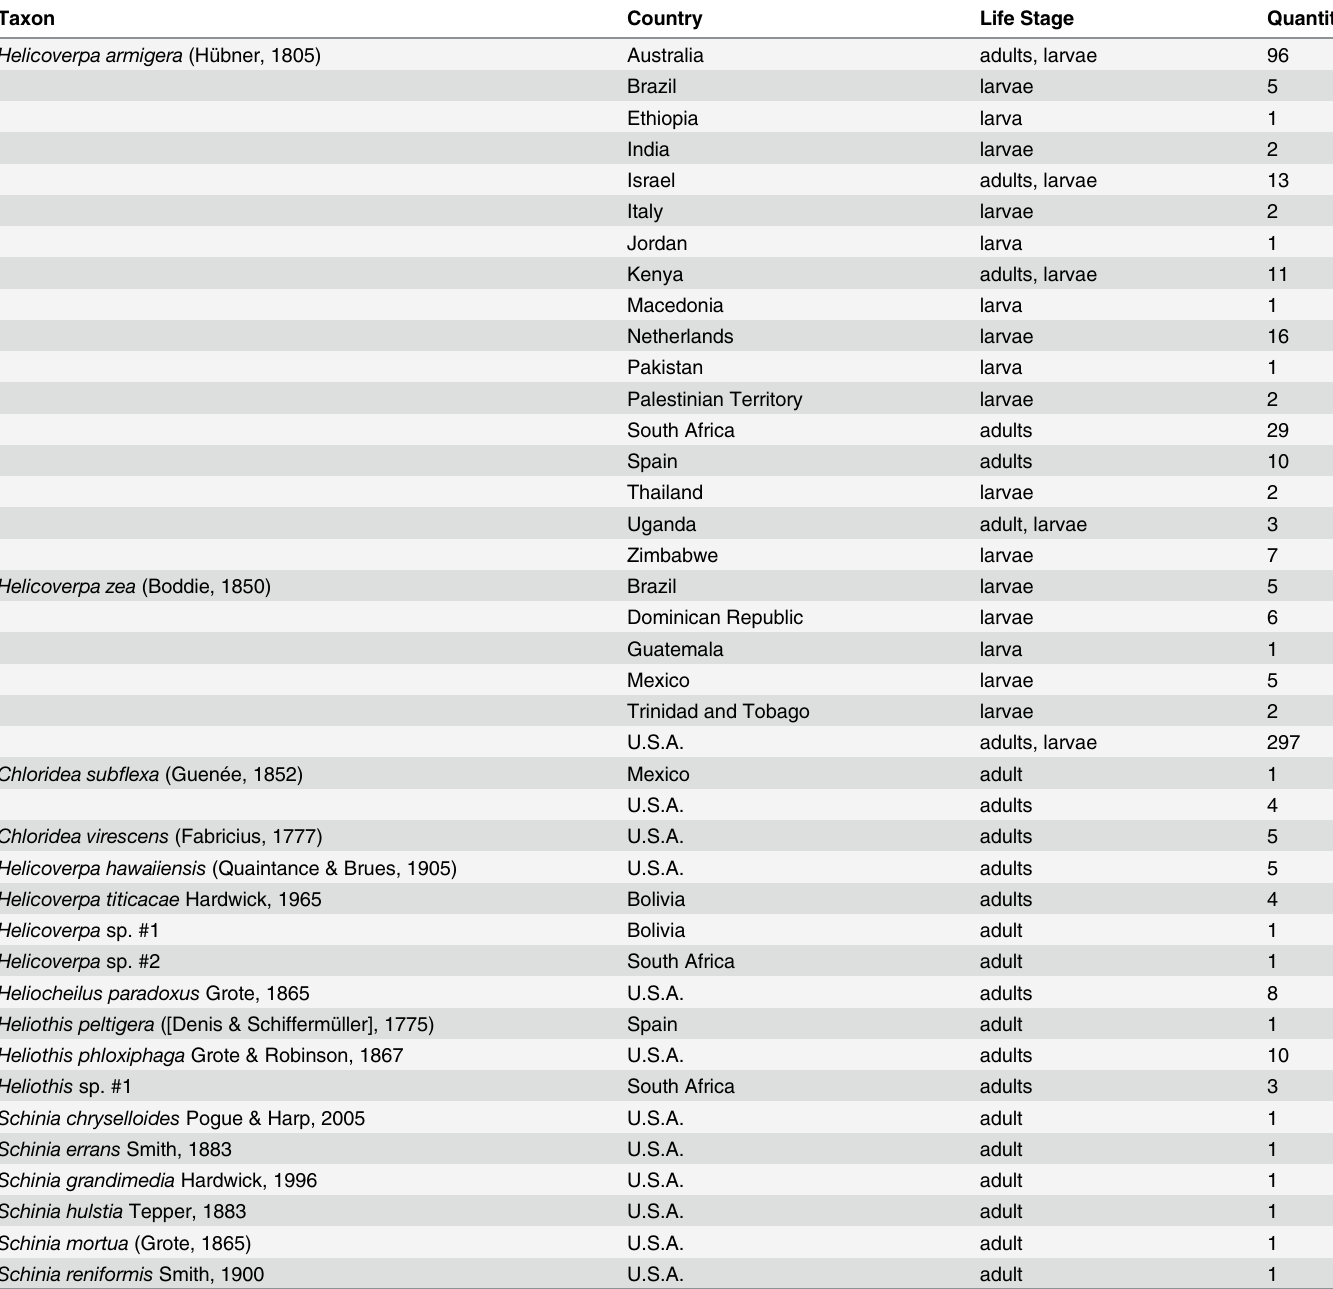
Table 1. Taxa sampled for study with country of origin, life stage, and number of